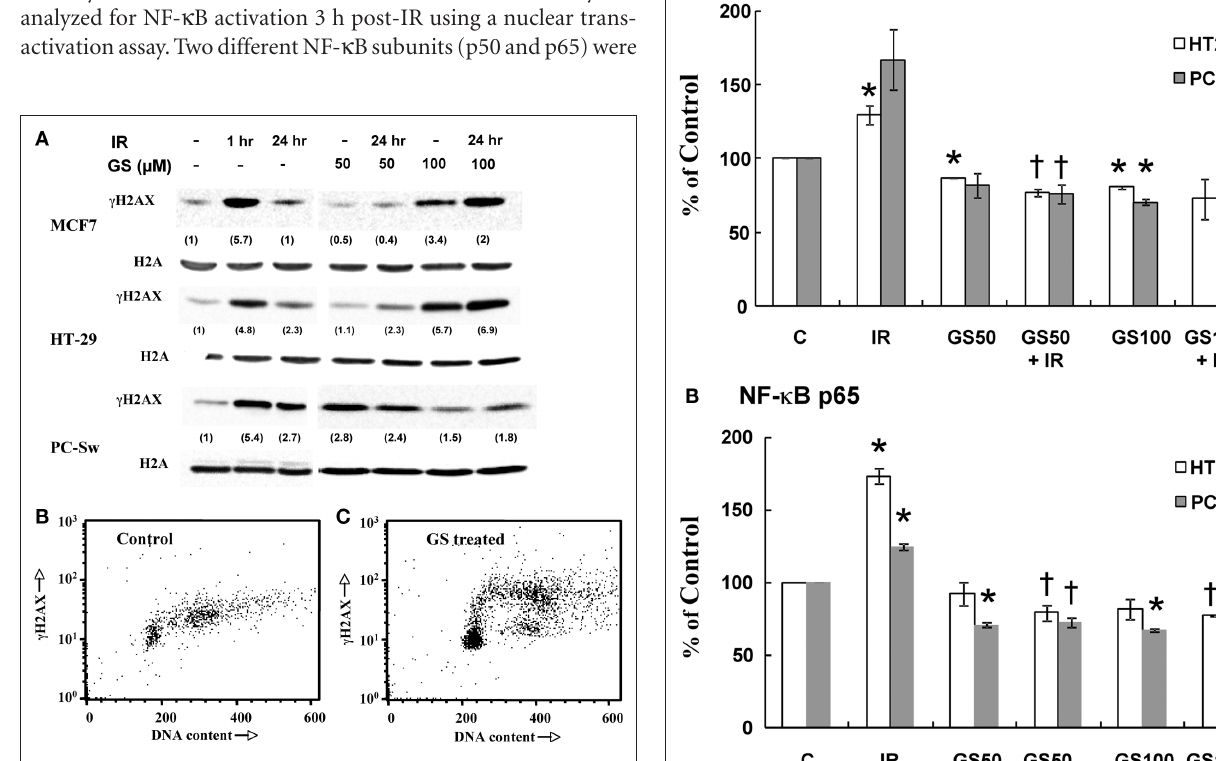
FiguRe 5 | effect of gS and iR exposure on γ H2AX formation in various cell lines. (A) MCF7, HT29, and PC-Sw cells were treated with 6 Gy IR alone, 50 or 100 μM GS for 24 h alone, or 50 or 100 μM GS for 24 h followed by 6 Gy IR exposure. Samples for γ H2AX induction were taken at 1 and 24 h. Two parameter flow cytometry histograms of γ -H2AX versus DNA content in control (B) or GS treated (C) PC-Sw cells. Cells were treated with 50 μM GS for 24 h and were then fixed and analyzed using an anti- γ H2AX antibody and co-stained with PI for total DNA content.